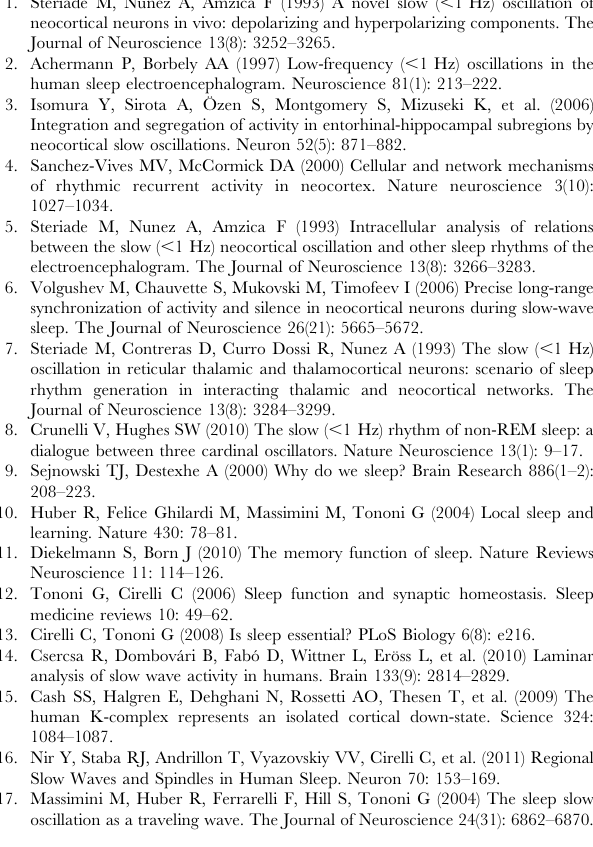
the hubs that preferentially perform the first detection and the red crosses mark the hubs that preferentially perform the last ones. (TIF) Table S1 Details of the intracranial implantations. Contacts in the epileptic ictal zone correspond here to contacts associated to seizure onsets. Contacts in the epileptic interictal zone correspond here to contacts associated to epileptic spikes during interictal periods. Contacts between two adjacent regions were considered as half in each one. Legend: Fro (Frontal), Par (Parietal), Occ (Occipital), Cin (Cingulate), Ins (Insula), Str